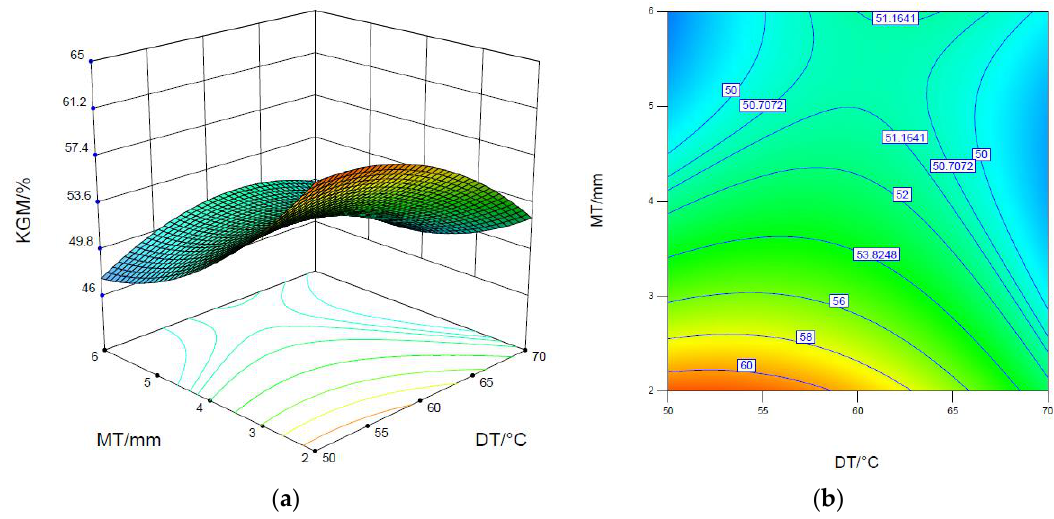
Figure 5. Response surface and ( a ) contour ( b ) for KGM content with respect to interaction term DT•MT at a constant DV of 0.05 MPa.